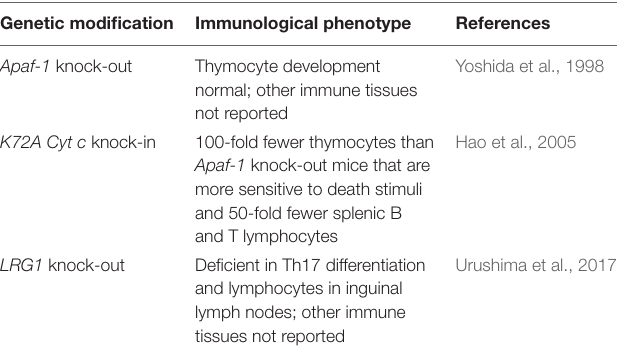
TABLE 2 | Immunological phenotypes of genetically modified mice with defects in Cyt c